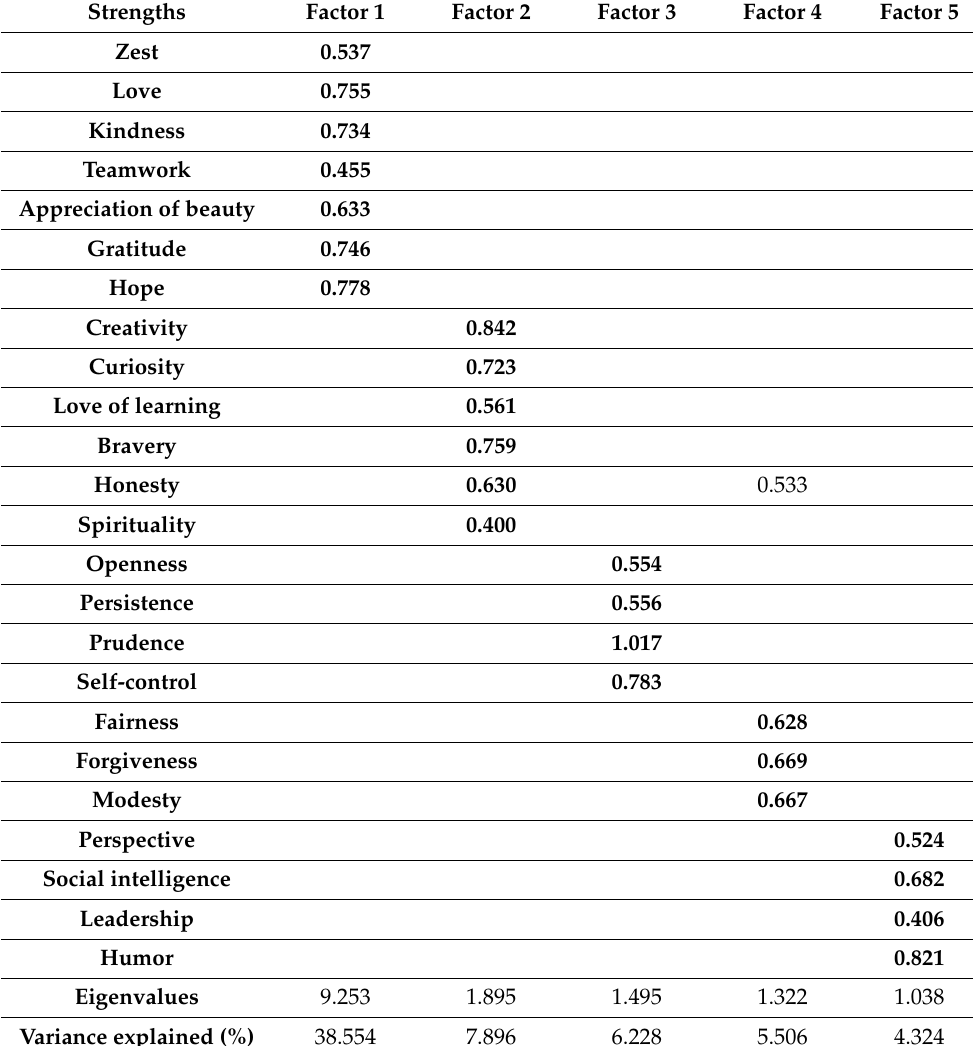
Table 2. Oblimin rotated solution of Principal Component Analysis for CCSQ ( n =